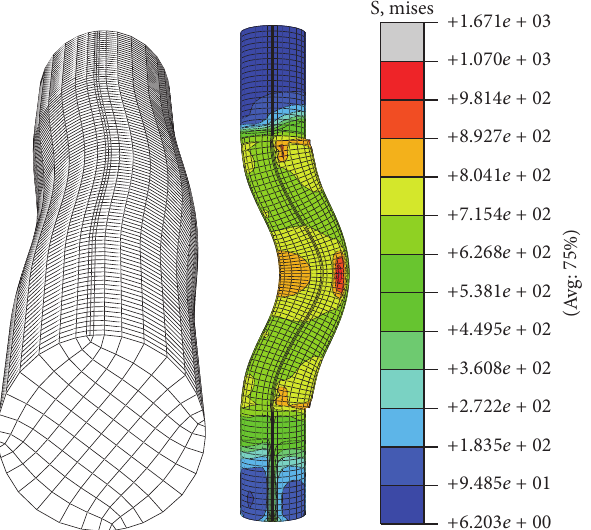
Figure 3: FE meshes of the 𝑙/𝑑 = 5 specimen, showing on the left the buckling mesh before the application of the loading, with initial imperfection in the form of the 1st mode, calculated by the eigenvector/value analysis. The maximum deflection is 1 mm. On the right is the contour plot of the von Mises stress at 10 mm axial displacement.Notehighlydistortedelementsintheregionsadjacent to the constraints. Also note that the location of the maximum stress is on the side surface, closer to the outer region with positive curvature, while at the same time the stress is higher at the saddle point (inner) than at the outer point, with the maximum deflection. This fact has important implications for postbuckling fatigue and fracture behaviour of reinforcing bars [1, 2,